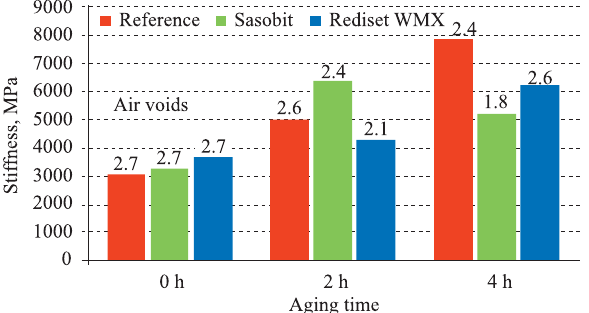
Fig. 6. Stiffness modulus after different aging times